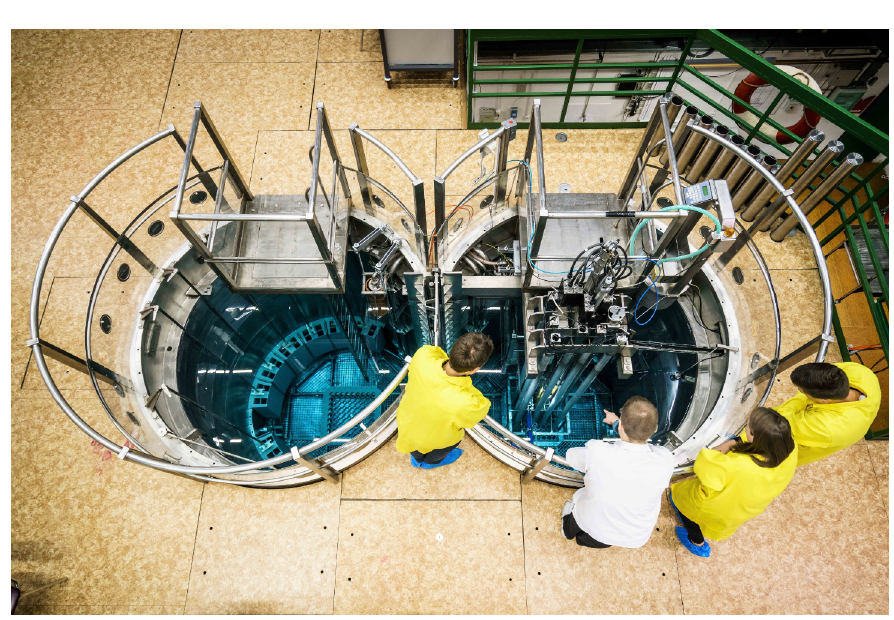
Figure 1: The Training reactor